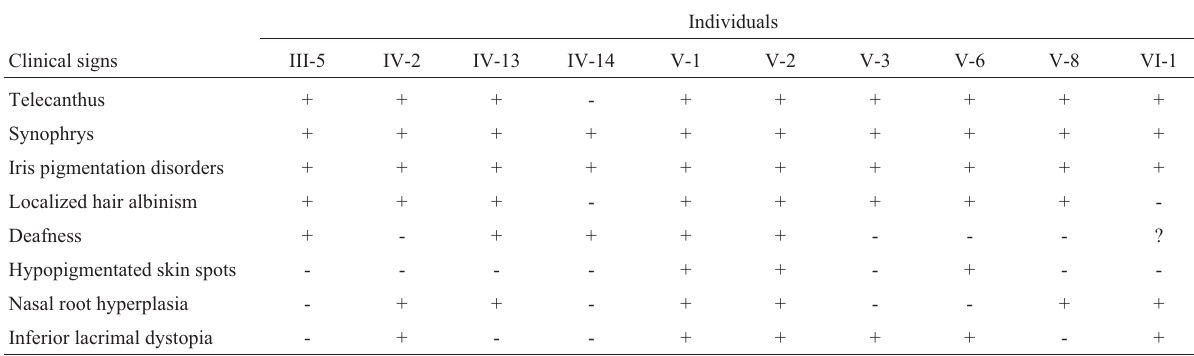
Table 1 - Distribution of the cardinal signs and symptoms of WS in ten personally examined patients of Family 2 (see Figure 1).